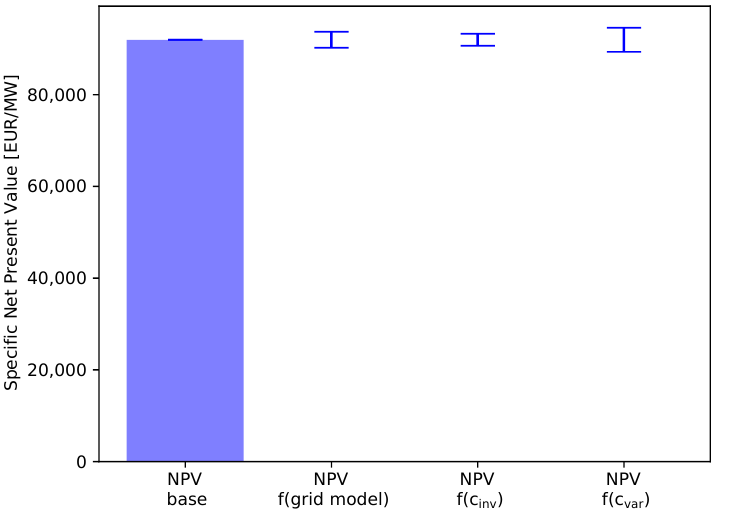
Figure 18. Influence of uncertainties in the open-source power grid model, the DR investment costs and the DR variable costs on the specific net present value for the example of the CTS-AC technology at a grid node close to the city of Dortmund. Annotation: base = result for the reference case; f() = results for using modified input parameters based on the considered